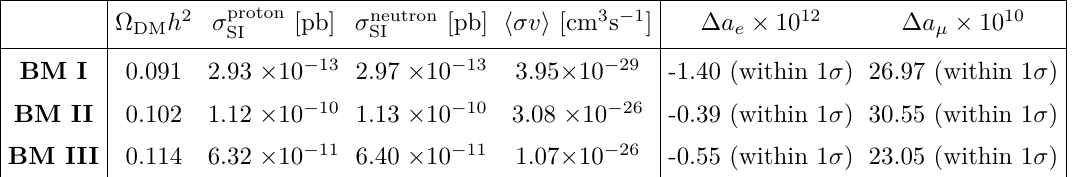
Table 7 . Predictions for the BM I , BM II and BM III scenarios, of the observables discussed in our dark matter and lepton g − 2